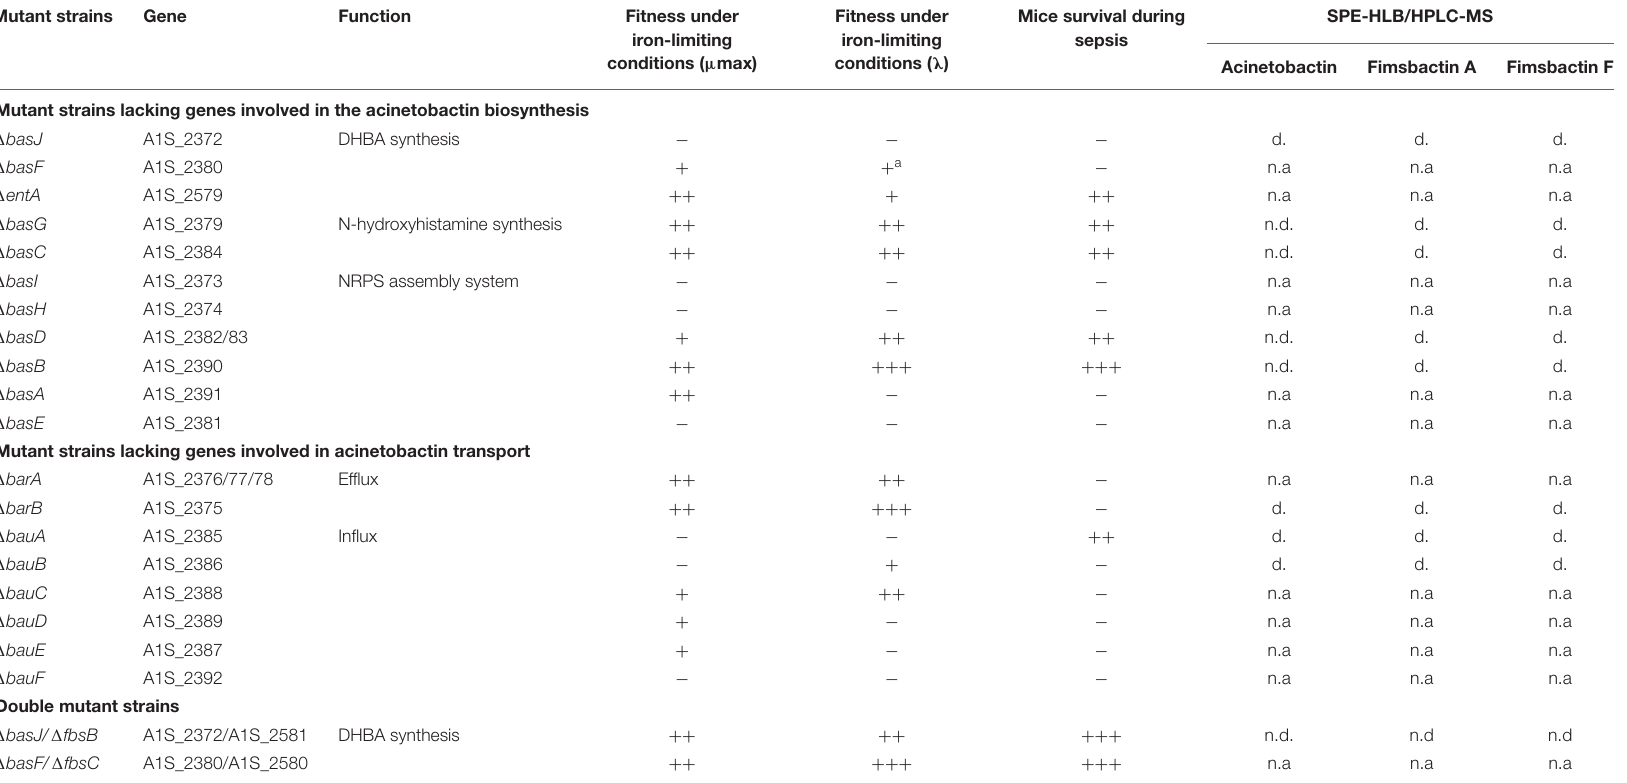
Statistical significance of bacterial phenotype differences observed in the mutant strains compared with the parental ATCC 17978 strain are indicated as follows: + , P < 0.01; ++ , P < 0.05; +++ , P < 0.0001 and − , no difference. a Mutant decreased λ compared to the parental strain. d. = detected.